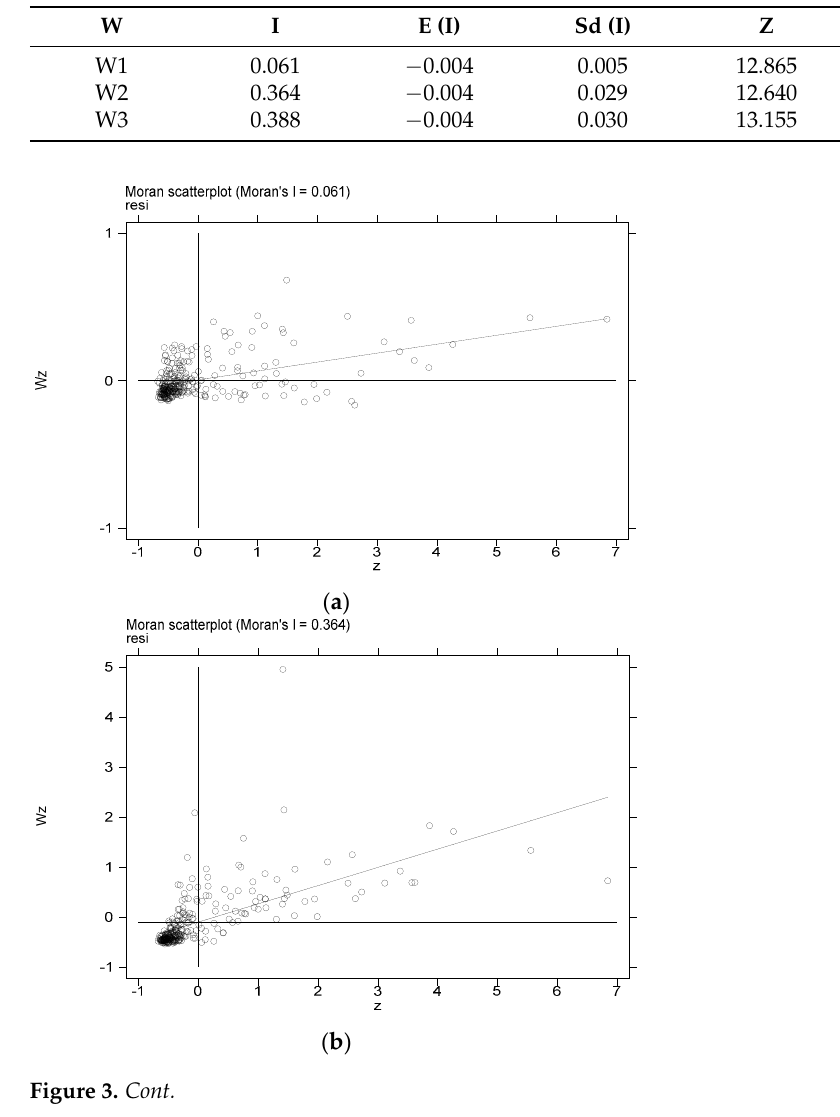
Table 3. Urban economic resilience global Moran’s I.